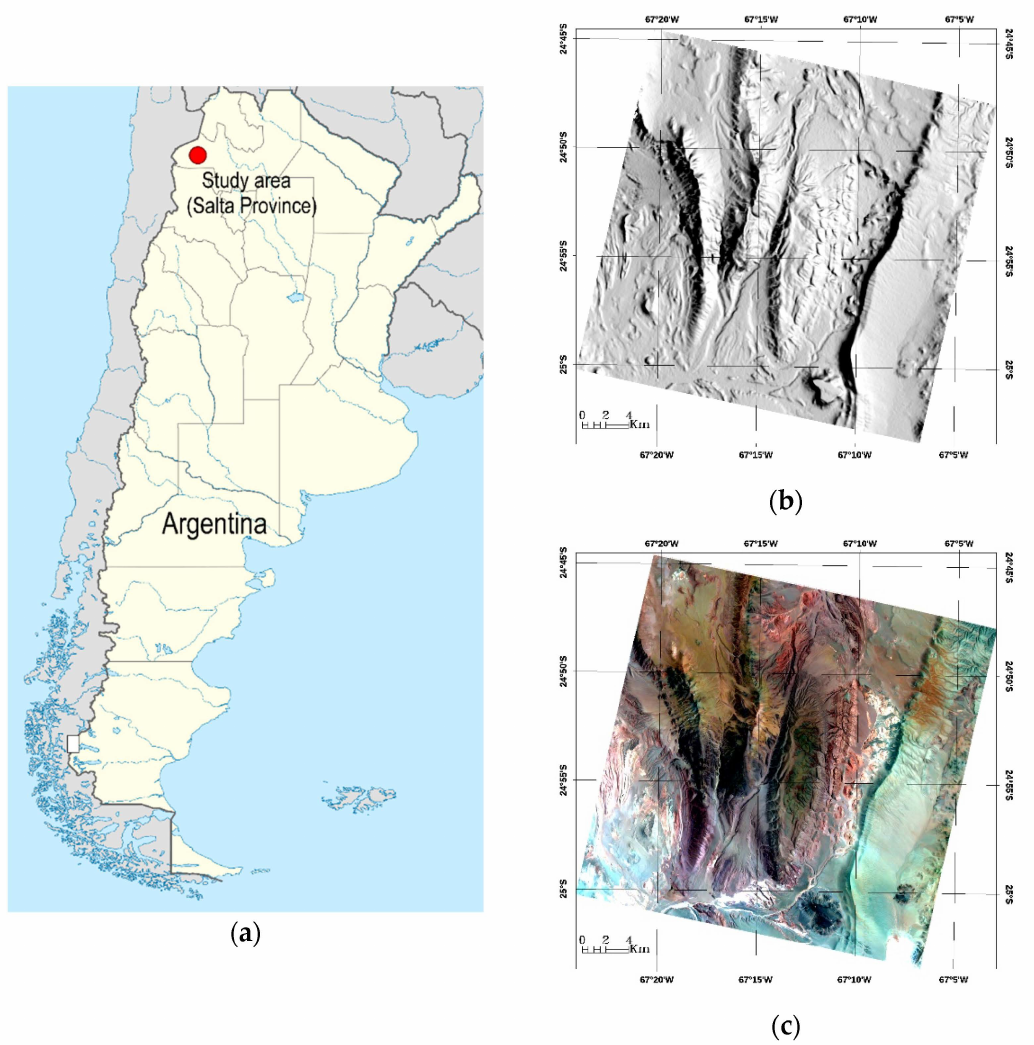
Figure 1. ( a ) Study area; ( b ) ENVI hill-shade image obtained by the DEM; ( c ) PRISMA RGB of the study